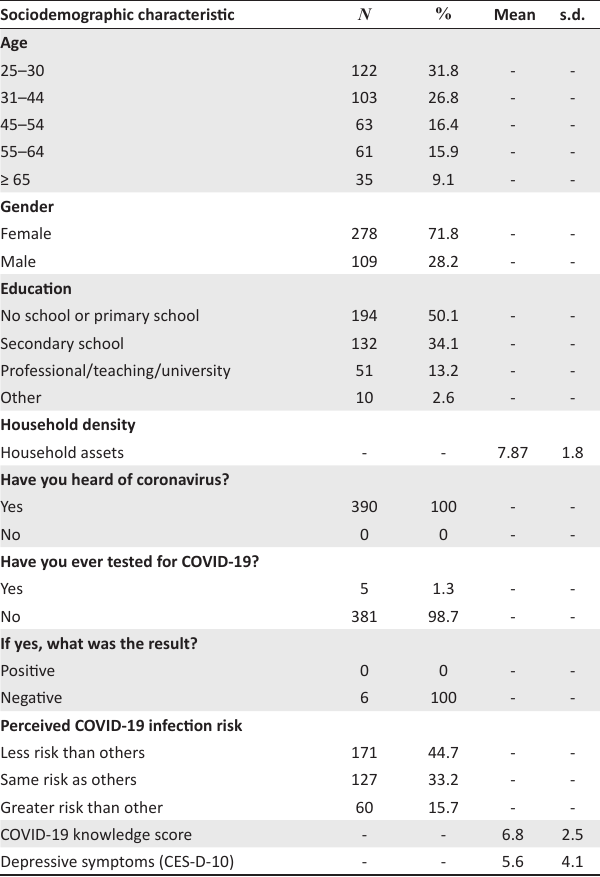
TABLE 1: Socio-demographic characteristics of the sample ( n = 391). Sociodemographic